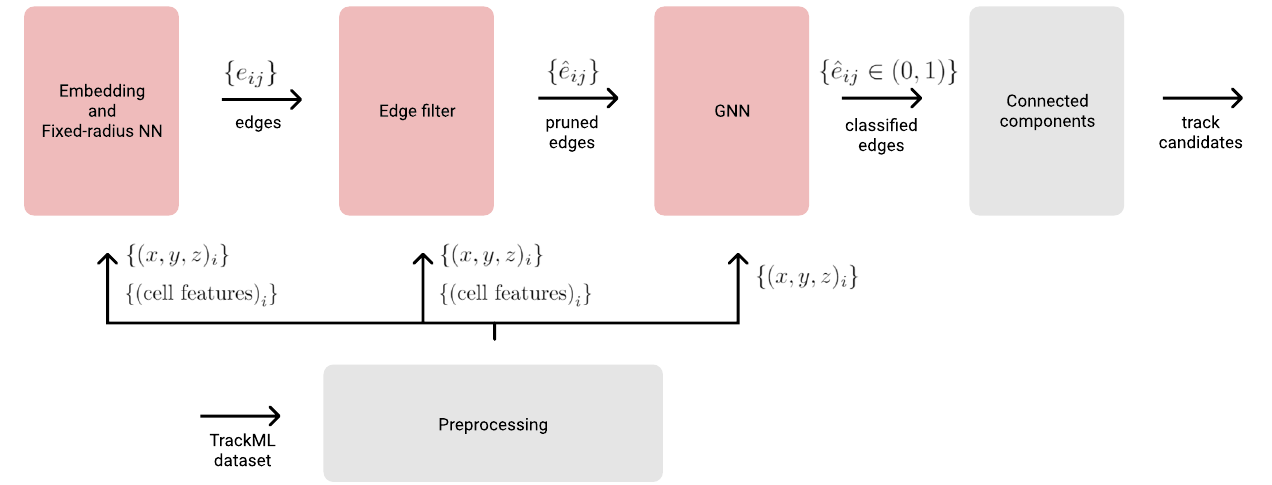
Fig. 3 A typical event distribution of spacepoints projected on the x - z plane, parallel to the beam direction (left), and the x - y plane, orthogonal to the beam direction (right)